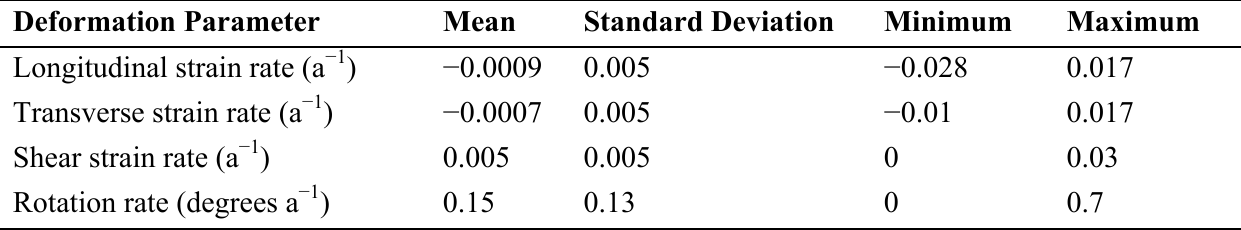
Table 7. Summary statistics of the computed deformation parameters of the La Clapière landslide.